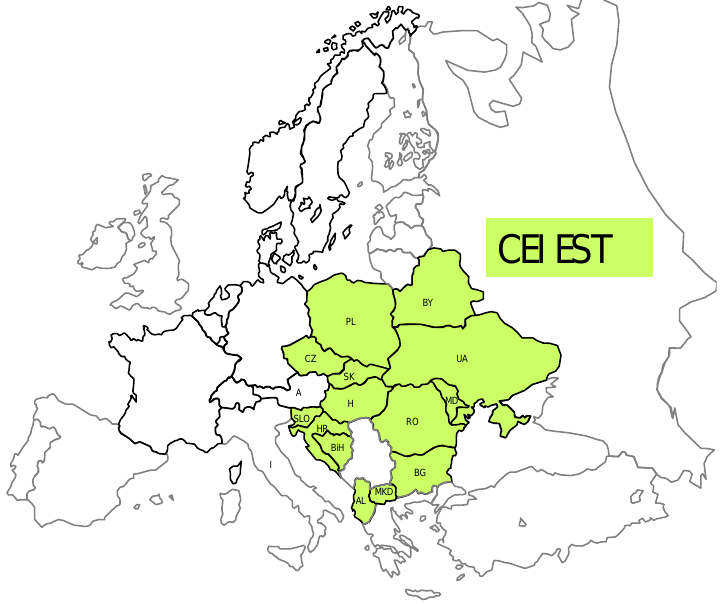
Figure1 . Study area of the CEI countries The CEI countries under study make up a highly heterogeneous group, with markedly different historical, geographic, political and economic profiles. Some countries, like the Czech Republic and Poland are highly industrialized and have recently enjoyed economic growth, others such as Albania, are agricultural nations, while countries like Bosnia-Herzegovina are in the midst of a painful reconstruction following